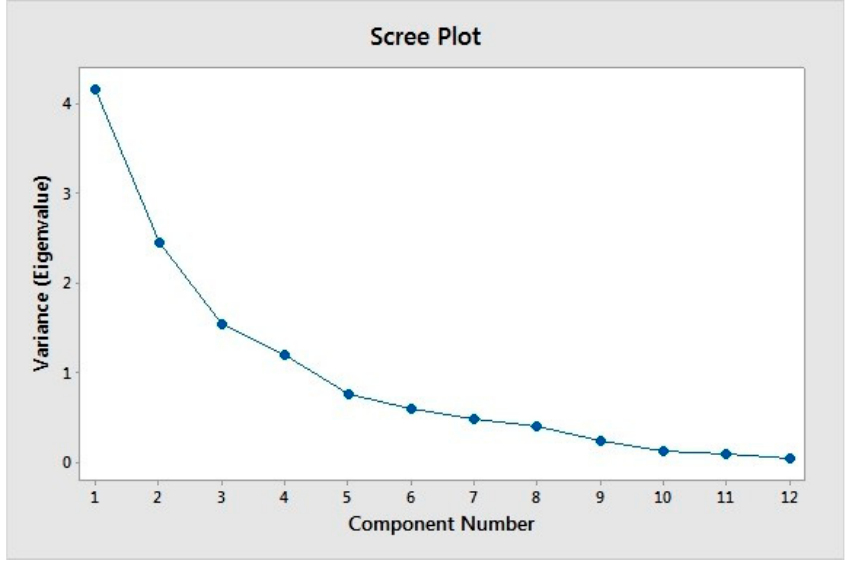
Figure 7. Scree plot of components.